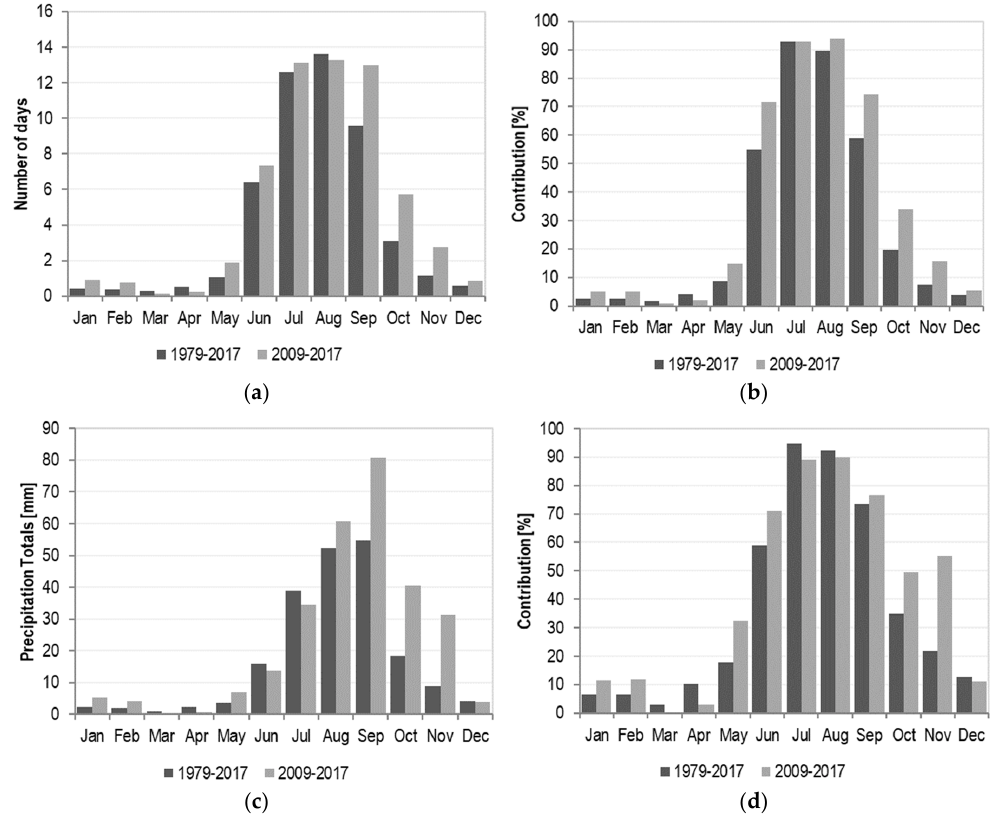
Figure 3. Monthly values of liquid precipitation characteristics in the 1979–2017 (dark bars) and 2009–2017 (light bars) periods: ( a ) number of days with liquid precipitation, ( b ) contribution of liquid precipitation to overall number of days with precipitation, ( c ) liquid precipitation totals, and ( d ) contribution of liquid precipitation to the overall precipitation totals.